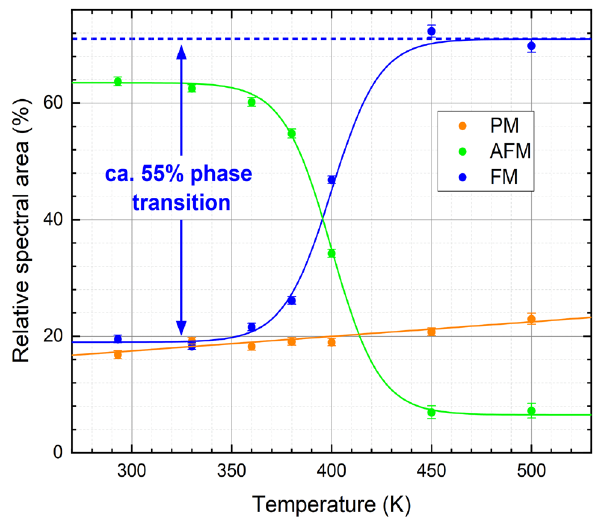
Figure 3. Mössbauer spectra of FeRh nanoparticles after annealing recorded at a temperature range of 30 – 500 K. Subspectra can be assigned to the low-temperature AFM state (green), the high-temperature FM state (blue), and an additional (super-) paramagnetic doublet contribution (orange).